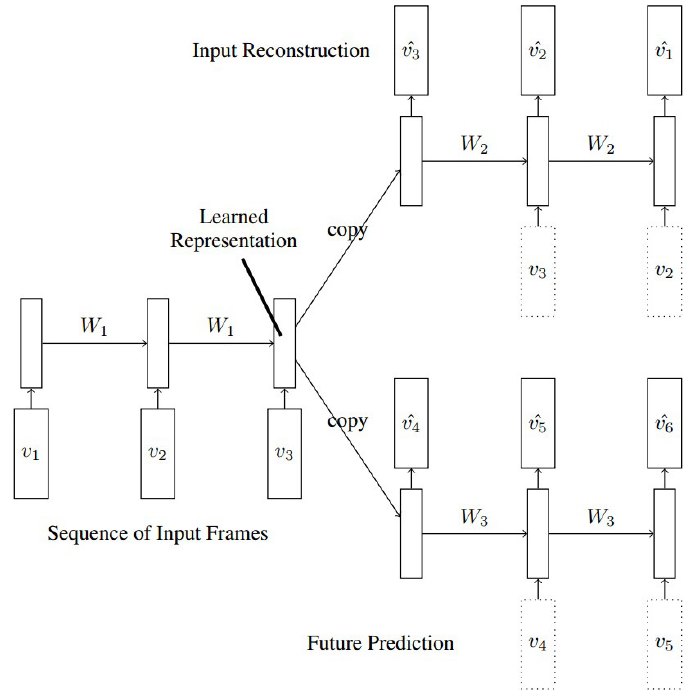
Fig. 2. The composite LSTM autoencoder model. The top branch reconstructs the input sequence backward in time, while the bottom branch performs frame predictions forward in time